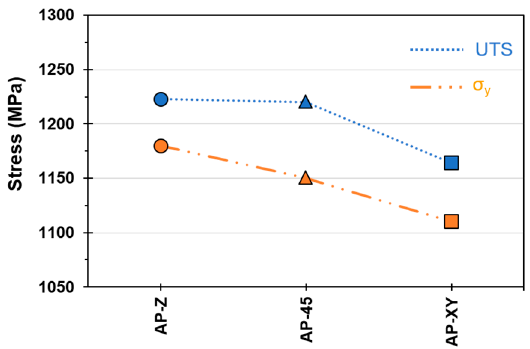
Figure 5. Effect of printing orientation on the ultimate tensile strength (top line) and yield strength (bottom line).